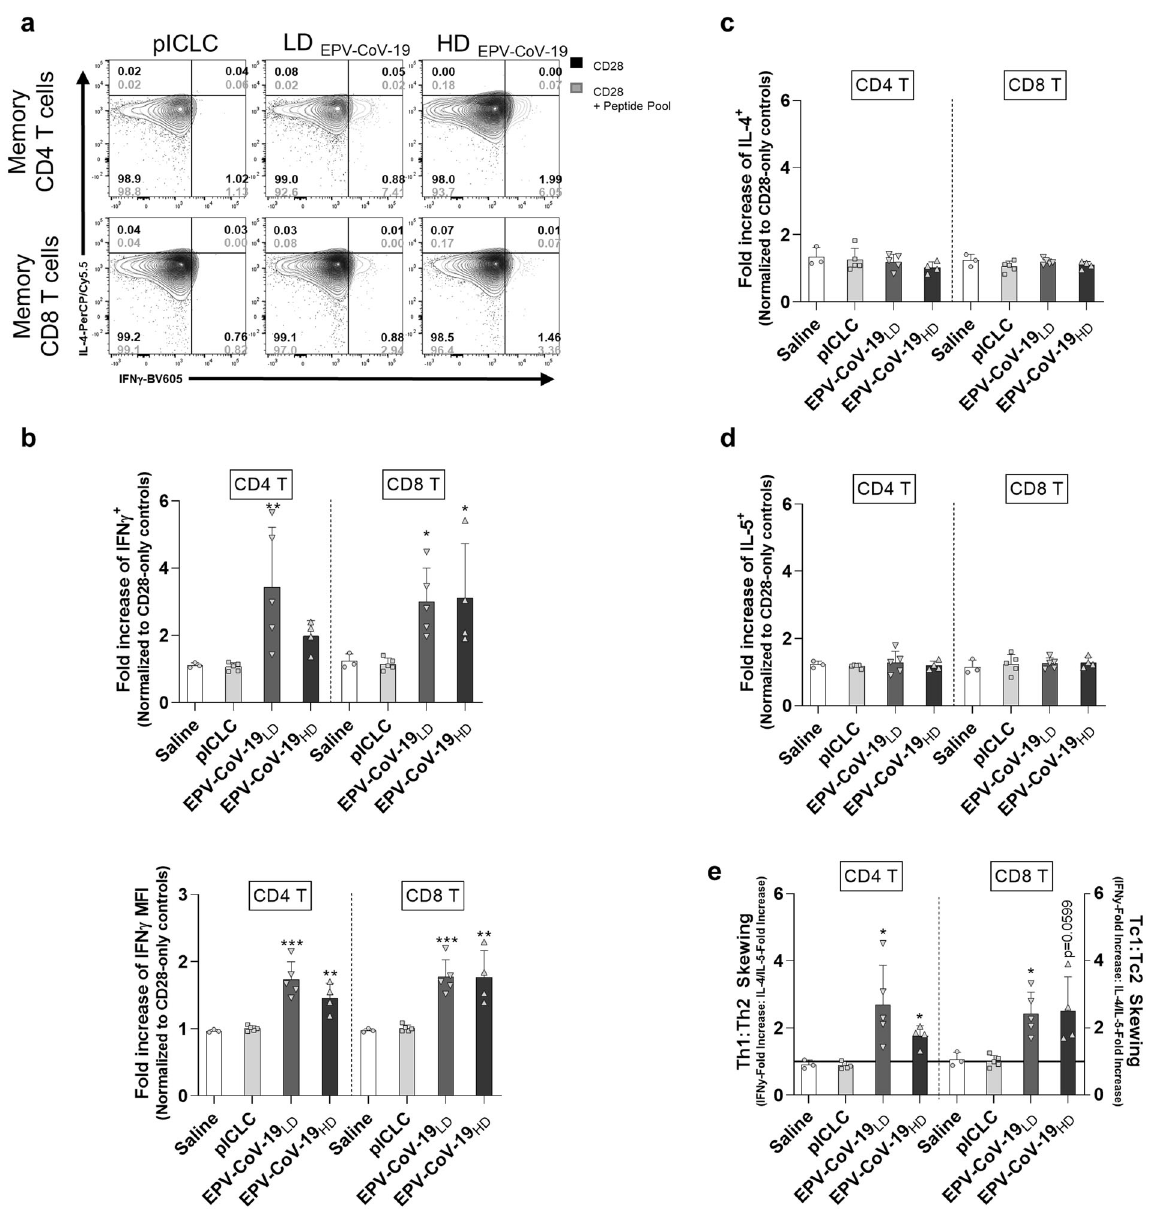
Fig. 5 EPV-CoV-19 immunization stimulates type 1-skewed memory CD4 + and CD8 + T cells in HLA-DR3 transgenic mice. Splenocytes were restimulated with a vaccine-matched peptide pool for 6 h in the presence of brefeldin A and monensin. Following incubation, cells were stained for surface markers, fi xed and permeabilized, stained for intracellular markers, and expression of markers was recorded by fl ow cytometry. Memory CD4 + T cells and CD8 + T cells were assessed for IFN γ , IL-4, or IL-5-production (both frequency in parent T-cell population and mean fl uorescence intensity (MFI) of cytokines). a Representative images of type 1 and type 2 skewed, epitope-speci fi c memory T-cell populations are shown. b The fold increase of epitope-speci fi c responses (over anti-CD28 stimulated controls) identify vaccine-speci fi c induction of IFN γ , but not c IL-4 or d IL-5. e From ICS generated data, we calculated the fold increase of IFN γ or IL-4- and/or IL-5-producing cells with peptide restimulation, and used the ratio of type 1-to-type 2 responses to model Th-skewing and Tc-skewing in vaccinated animals. Error bars depict SD. Saline n = 3, pICLC n = 5, EPV-CoV-19 LD n = 5, EPV-CoV-19 HD n = 4, * p < 0.05, * p < 0.01, *** p <